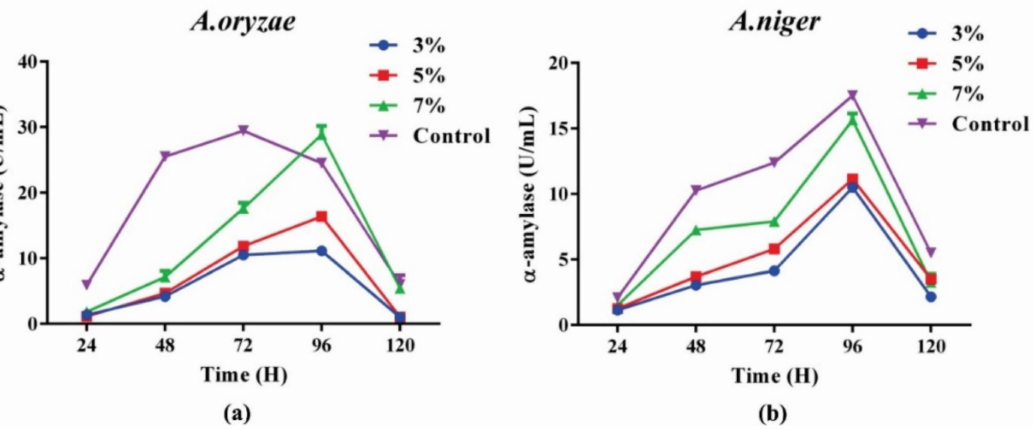
Figure 6. α -amylase enzyme production through fungal fermentation of pigment free de-oiled biomass: ( a ) by A. oryzae ; ( b ) by A. niger